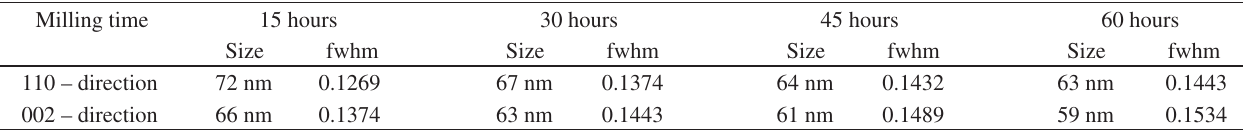
Table 2. Average grain size of the samples with high milling time. Average error is 1 nm. Milling